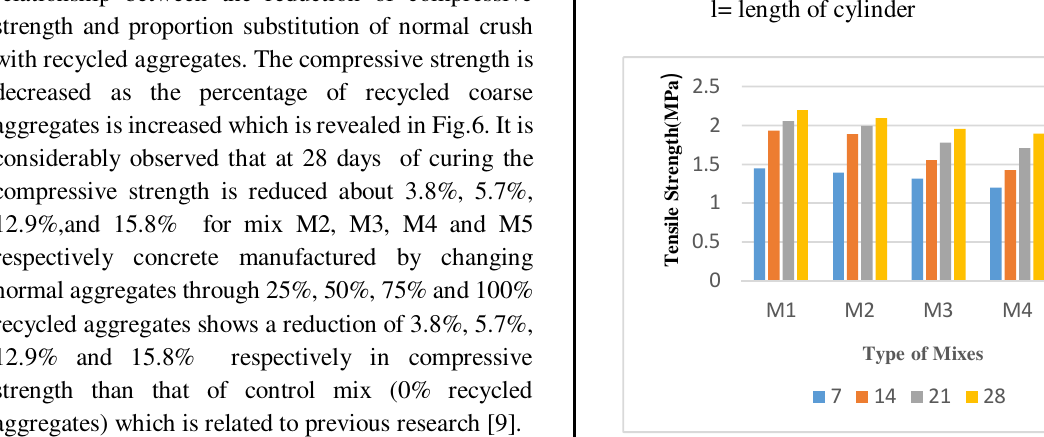
Fig. 7: Splitting tensile strength of concrete by substituting the normal crush with various proportions of recycled